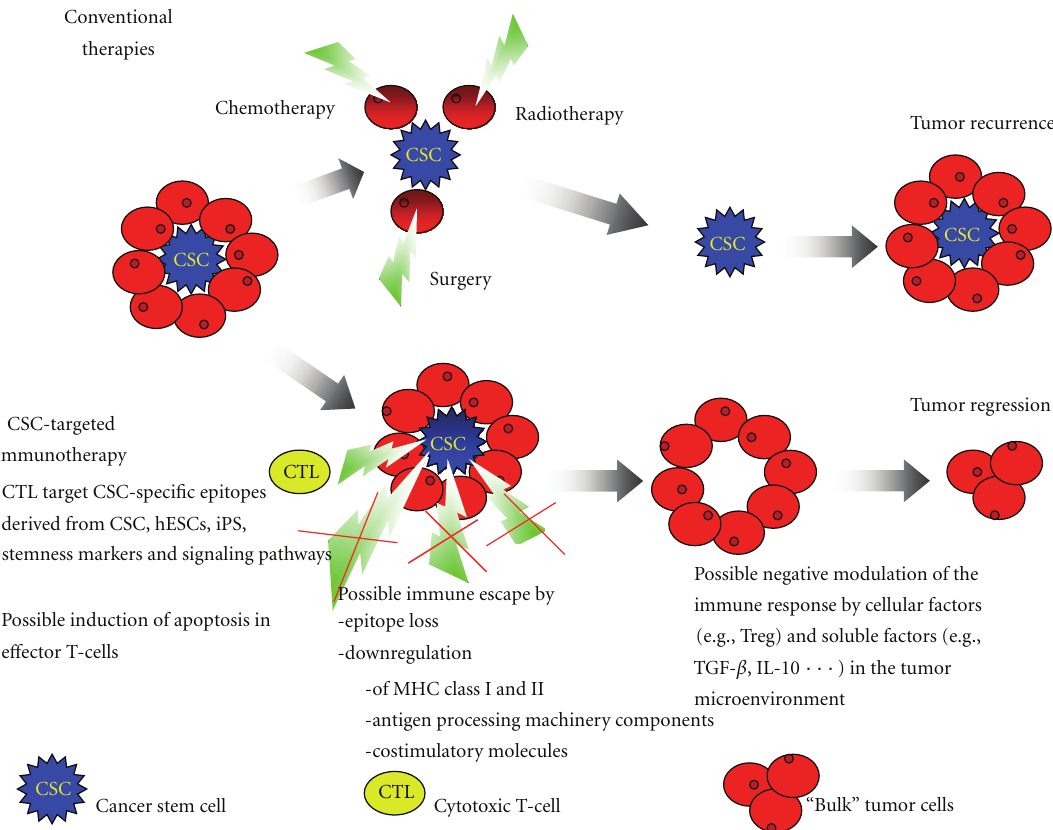
Figure 2: Comparison of the e ff ects of a failed conventional therapy and the outcome of a hypothetical CSC-targeted immunotherapy. Currently applied conventional therapies target bulk tumor cells that are less resistant than CSC. This leads to initial shrinking of the tumor mass but eventually regrowth from residual CSC. An immunotherapeutic approach targeting CSC directly would cut o ff the rejuvenating supply of CSC and ultimately lead to tumor regression.